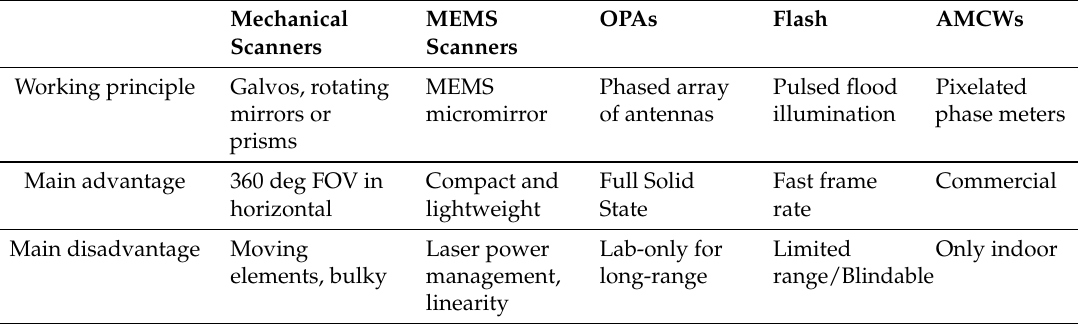
Table 2. Summary of imaging